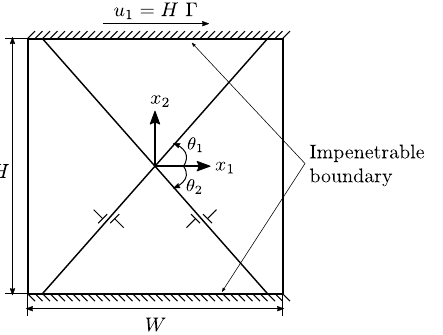
Figure 2. Simple shear of a constrained strip with two active slip systems.